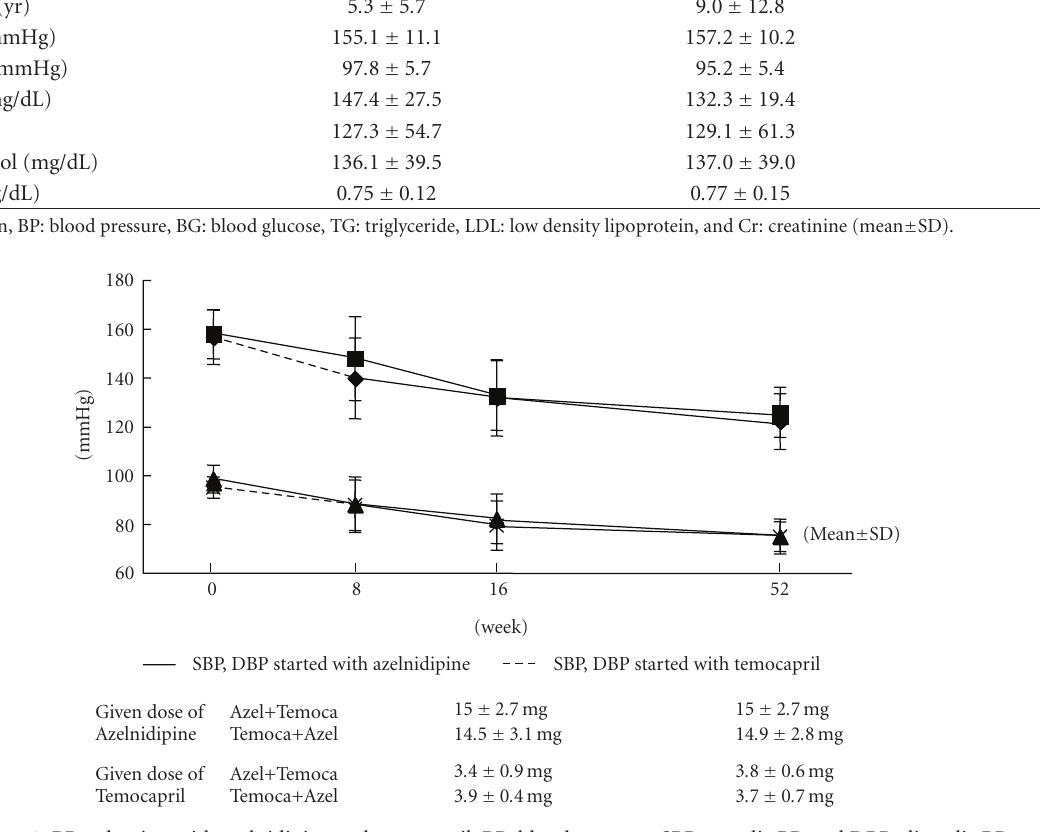
Figure 2: BP reduction with azelnidipine and temocapril; BP: blood pressure, SBP: systolic BP, and DBP: diastolic BP.